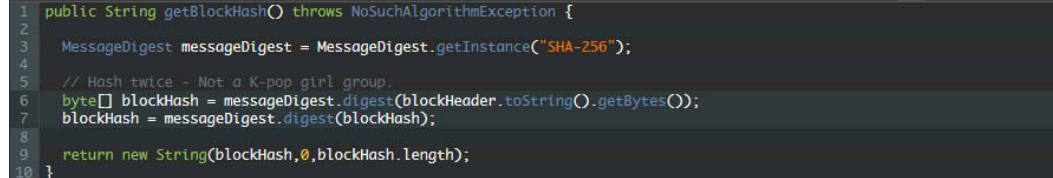
Figure 10. Computation of block hash using the rainbow SHA (secure hash algorithm)-256.